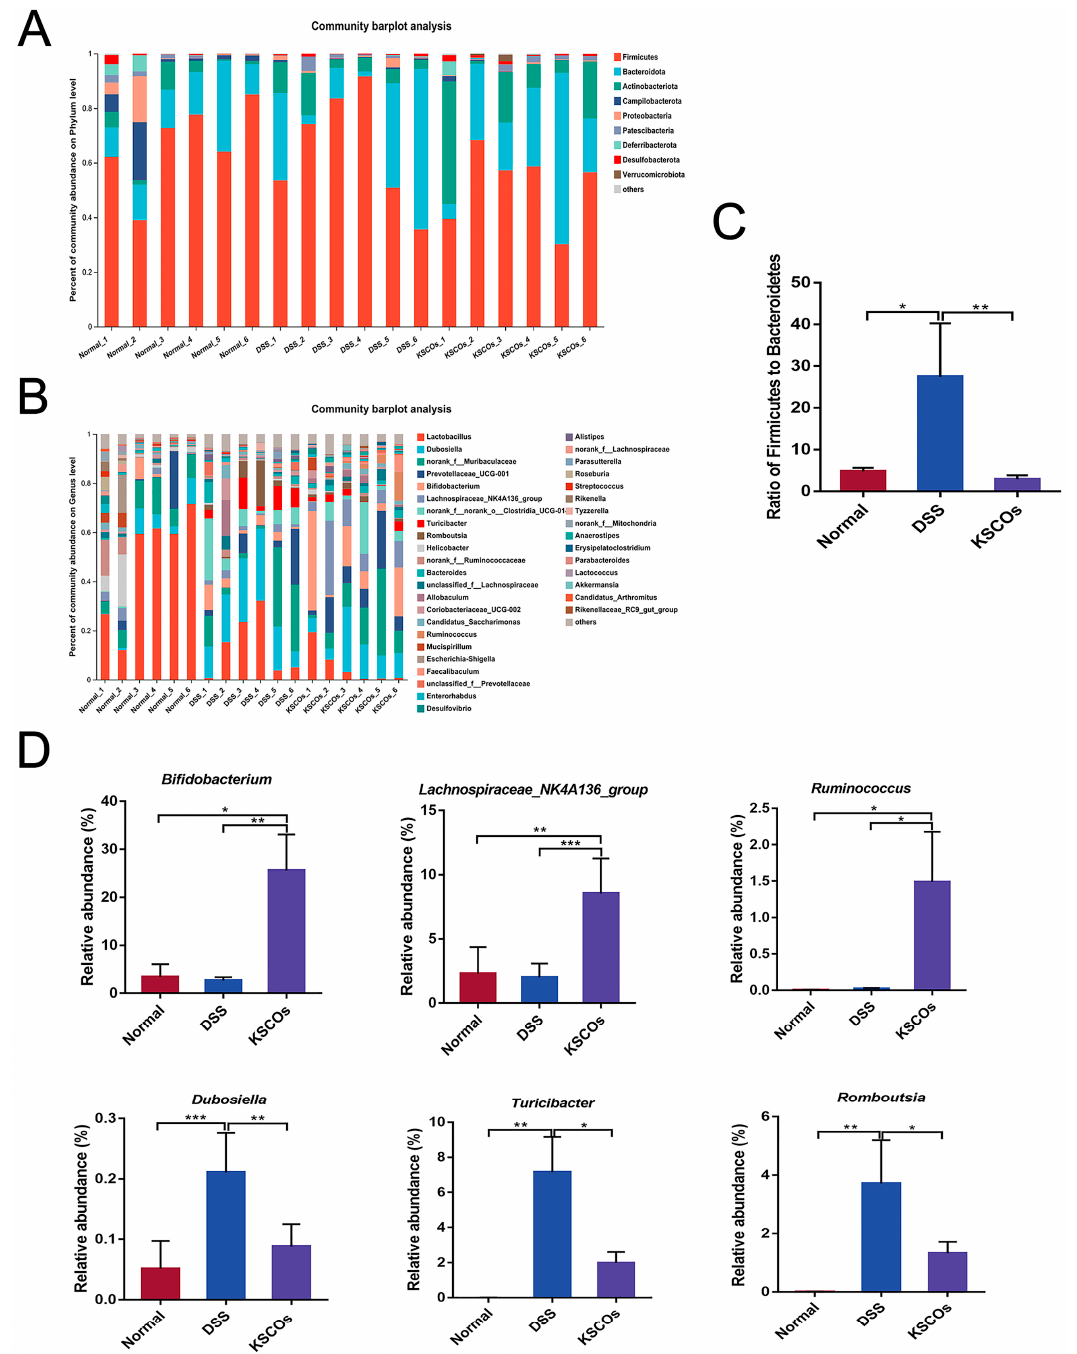
Figure 6. KSCOs modified the structure of gut microbiota: ( A ) the composition of gut microbiota at phylum level; ( B ) the composition of gut microbiota at genus level; ( C ) the ratio of Firmicutes to Bacteroidota (F/B); ( D ) different bacteria at the genus level. Data are shown as means ± SD, * p < 0.05, ** p < 0.01, *** p < 0.001.